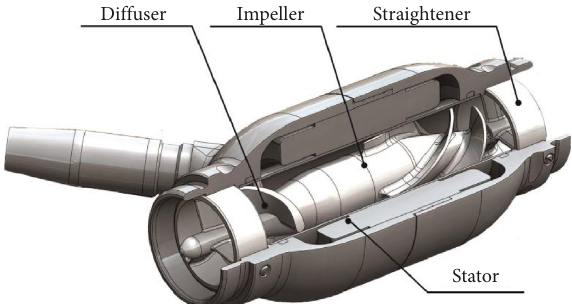
Figure 1: Profile of the Sputnik LVAD first-generation model. Four major parts of the device: (i) a straightener, (ii) a stator, (iii) an impeller, and (iv) a